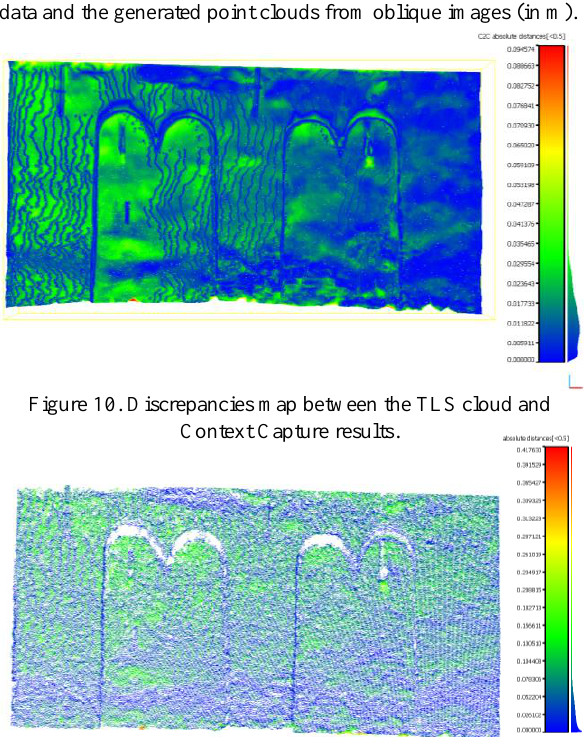
Table 2. Statistical values of the comparisons between the TLS data and the generated point clouds from oblique images (in m).